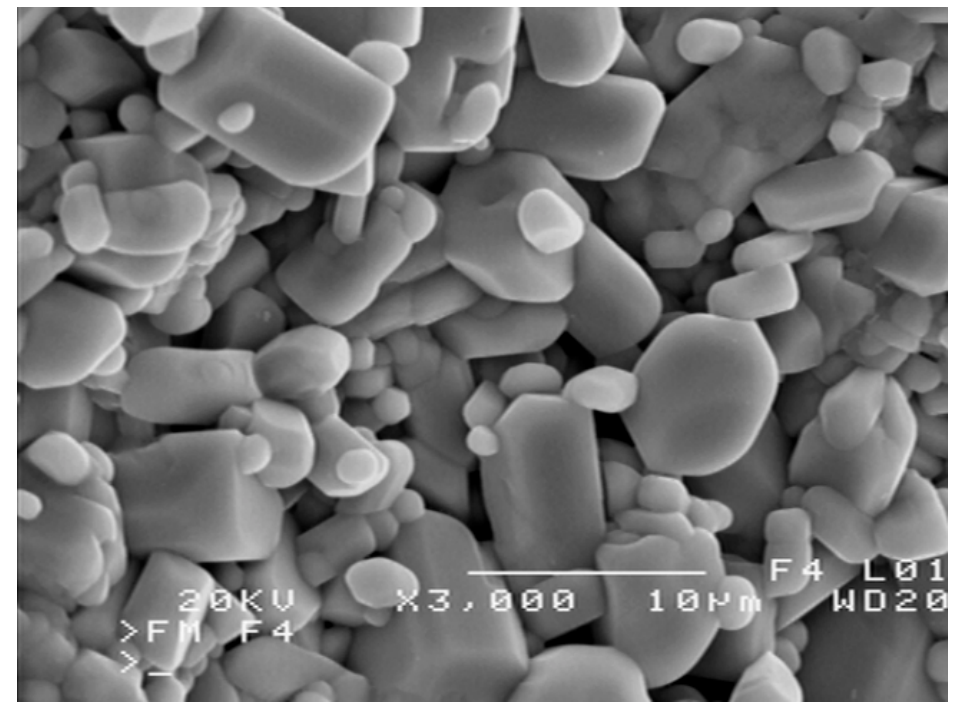
Figure 1. SEM image of ZnMgInV 3 O 11.